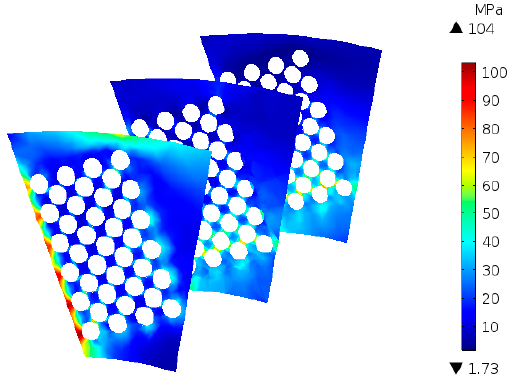
Figure 13. The von-Mises stress distribution in the epoxy at three different axial positions: 0, l /2 and l ; for non-uniform temperature distribution.